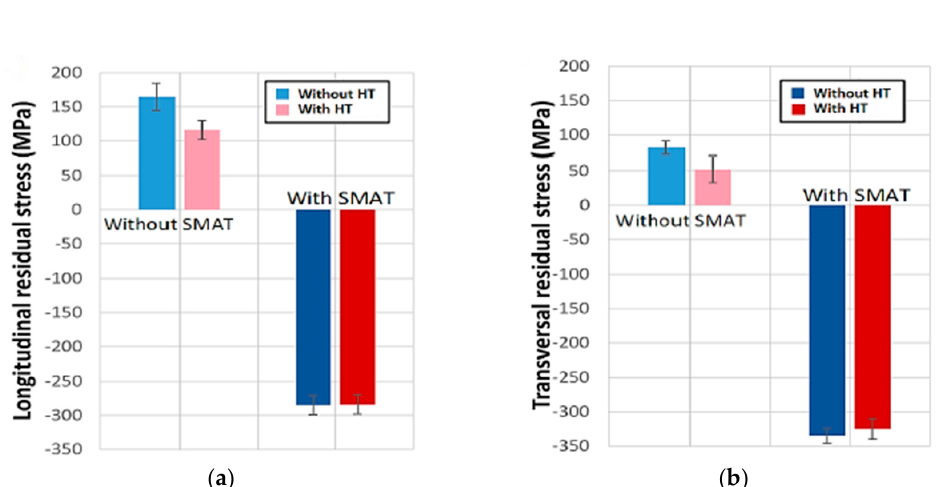
Figure 14. Post-treatment e ff ects on ( a ) longitudinal residual stresses and ( b ) transversal residual stresses. Adapted from [115], under CC BY